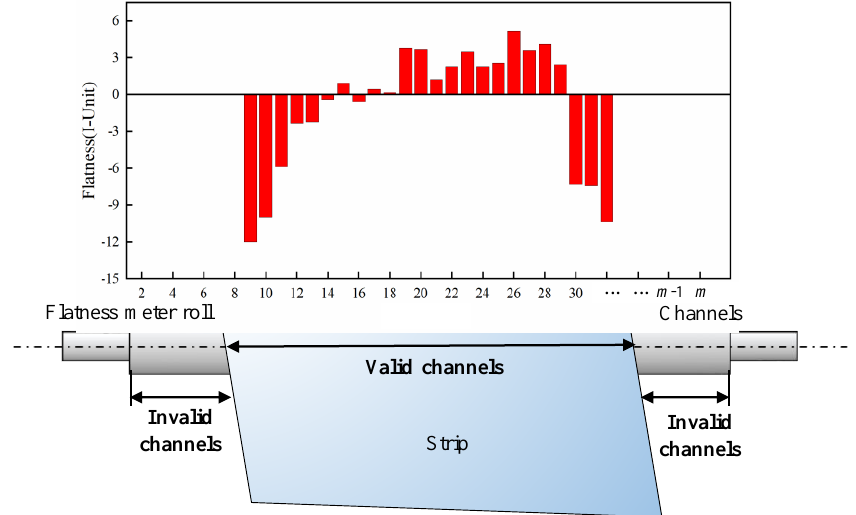
Figure 2. The diagram to determine the number of valid channels for the flatness detection roll.